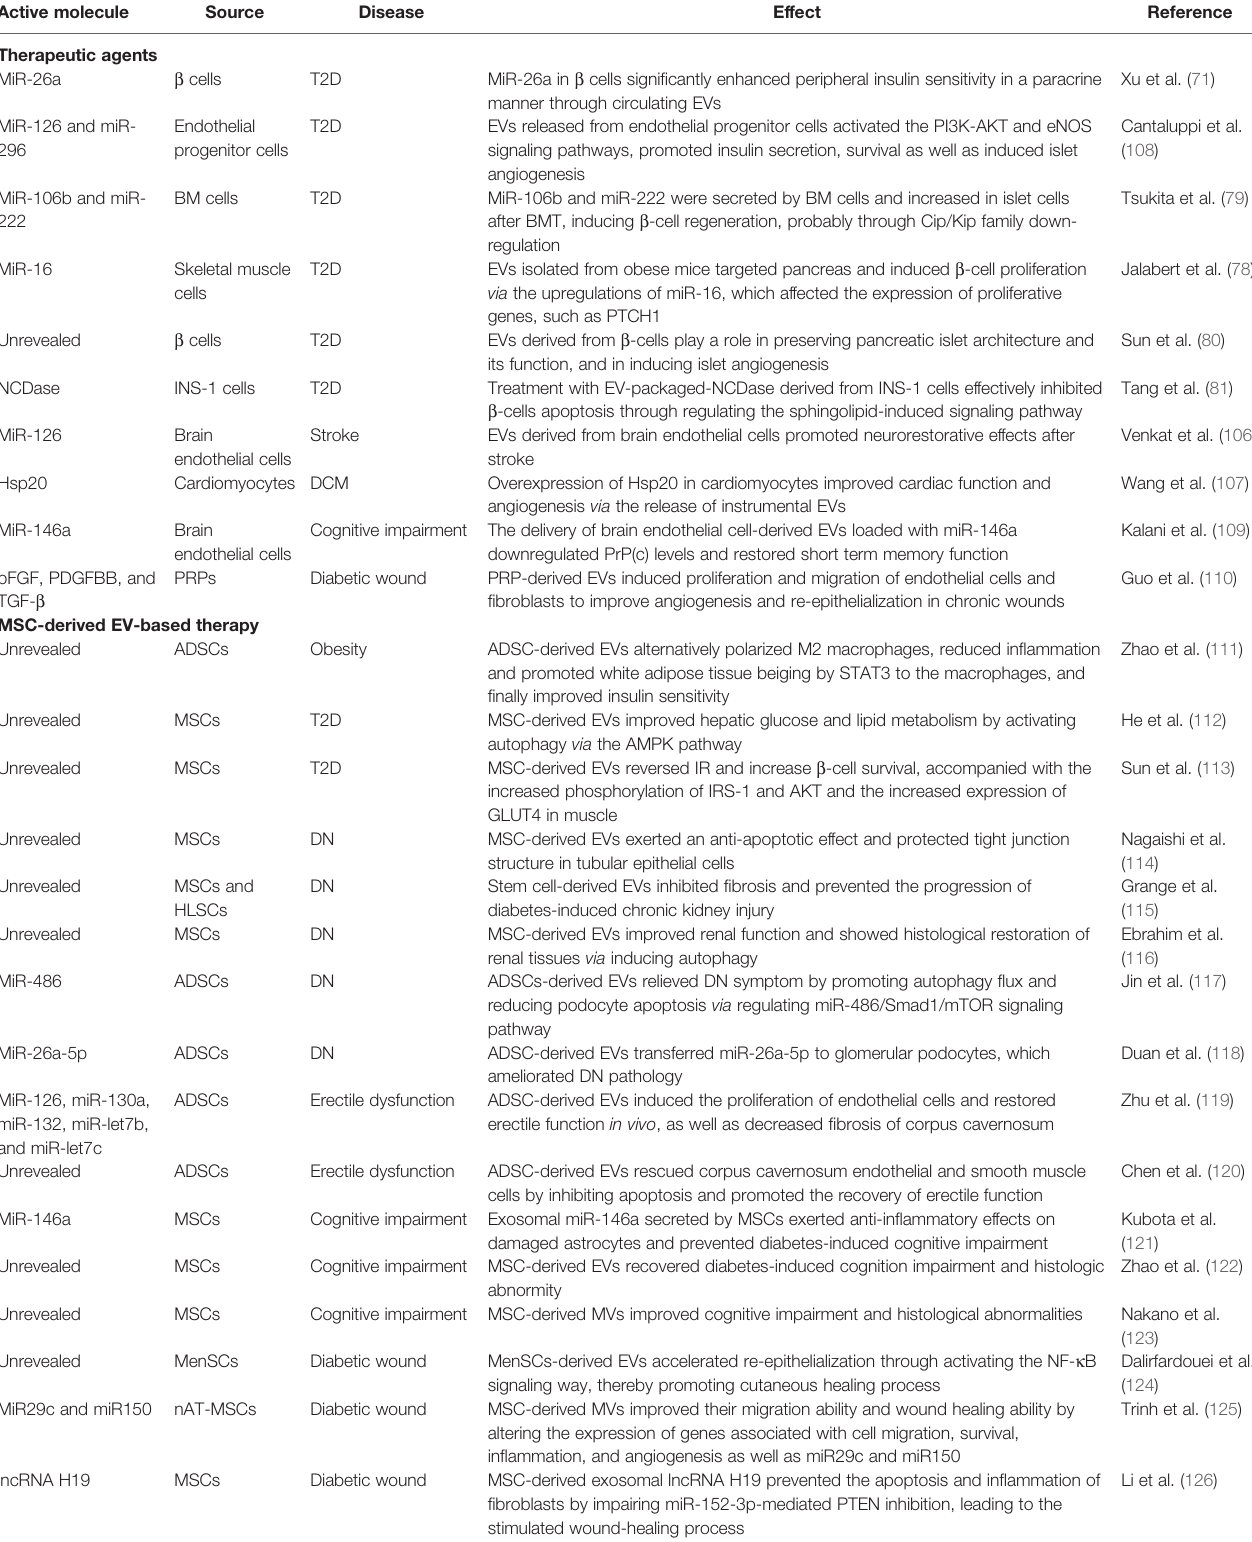
TABLE 2 | The application of EVs and mimics in the therapy of T2D and its